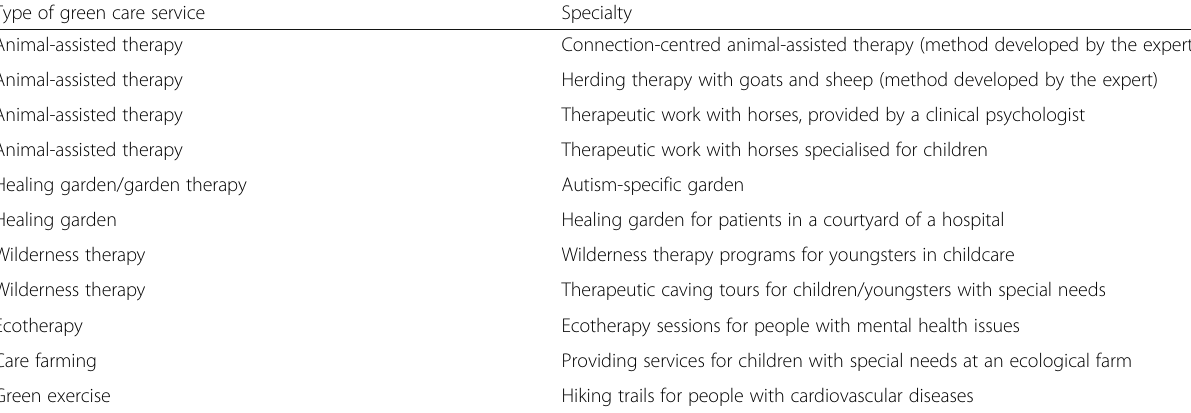
Table 2 A compilation of initiatives and practitioners, listing the different kinds of green care services, with examples and references to research/practice specialties in